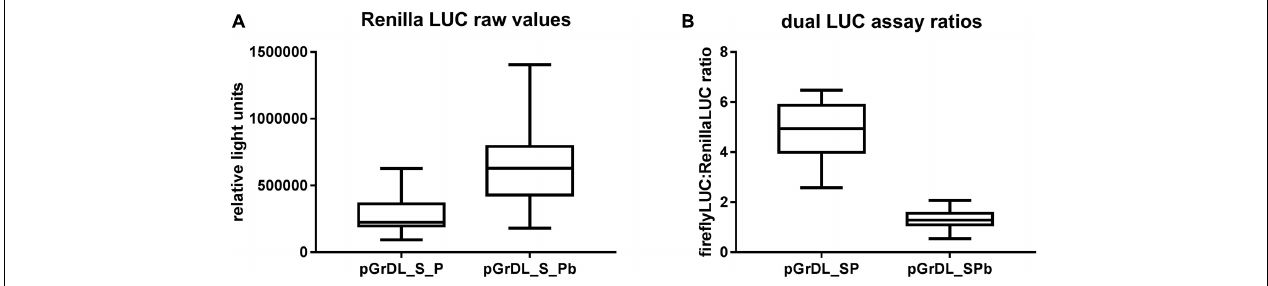
FIGURE 3 | Comparison of dual LUC plasmids pGrDL_SP and pGrDL_SPb. (A) Raw Renilla LUC relative light units generated from each plasmid. (B) Dual LUC ratios obtain from each plasmid. The results are depicted as box and whisker plots, with interquartile range boxes and min/max whiskers ( n = 18).